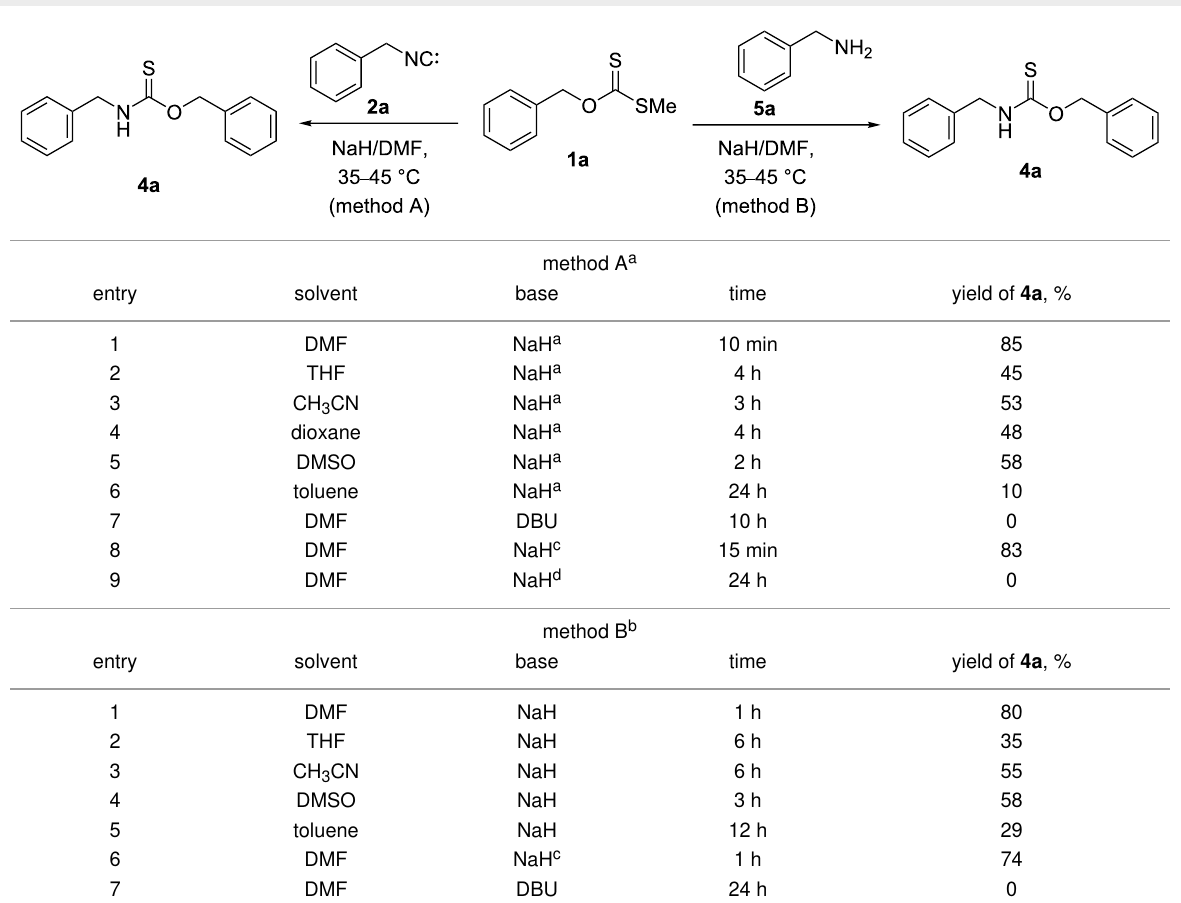
Table 1: Optimization data for the synthesis of 4a